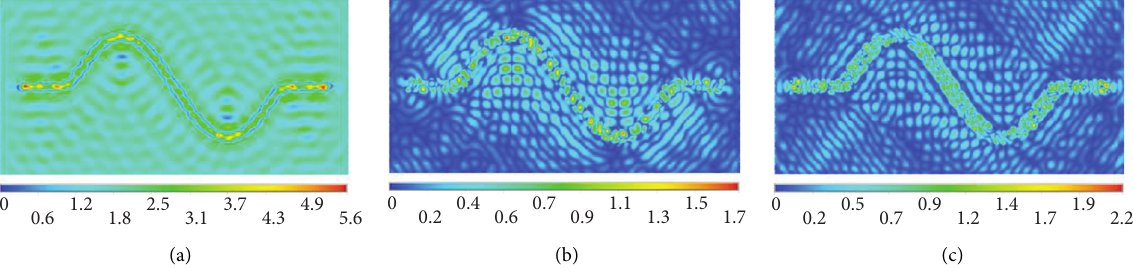
u u x , (b) y , and (c) z